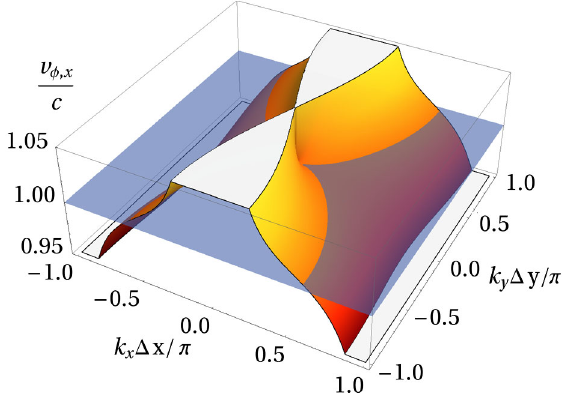
, as deduced (cid:5);x and k for electromagnetic x y ¼ 0 ). The blue horizontal z ¼ (cid:6)c with (cid:6) ¼ 1 (cid:1) 9 (cid:3) 10 (cid:1) 6 (which (cid:5);x